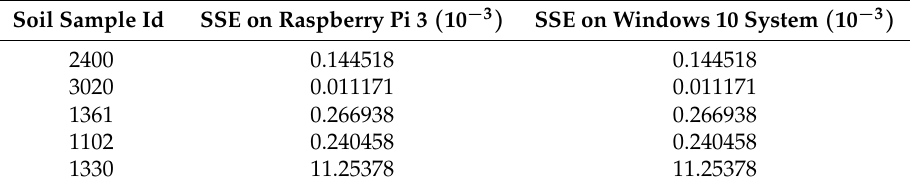
Table 4. SSEs of SSA on Raspberry Pi 3 and a Windows 10